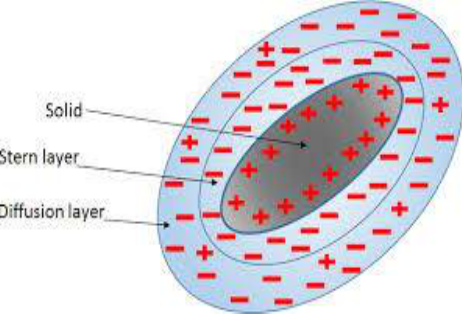
Figure 32. Model of positively charged colloidal particle [149].